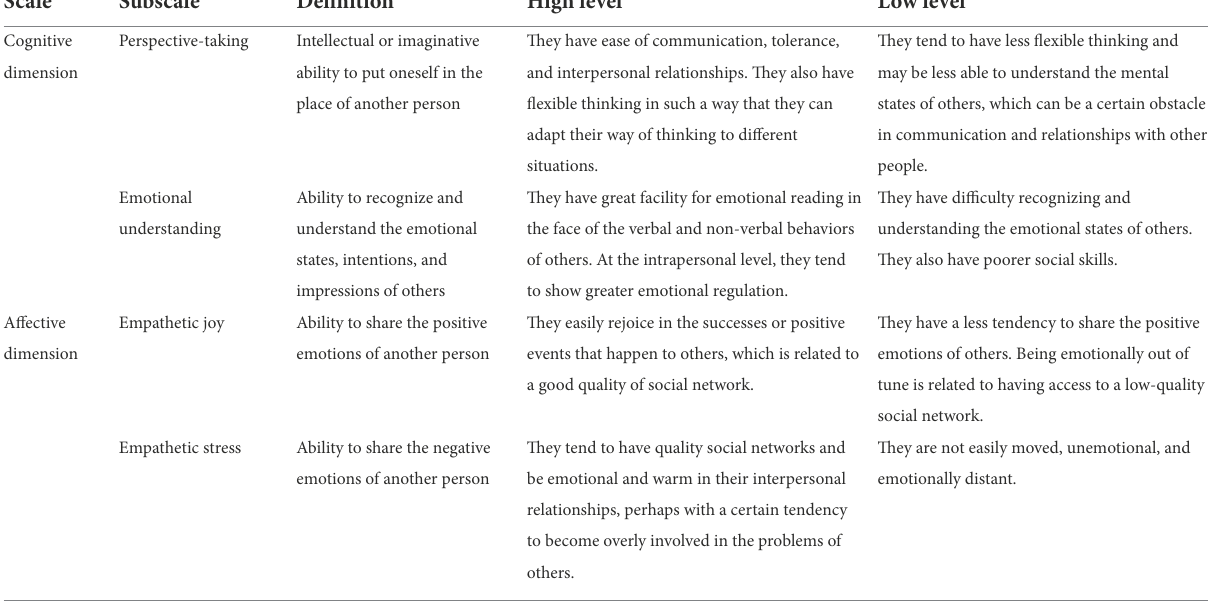
TABLE 1 Description of the dimensions of the TECA